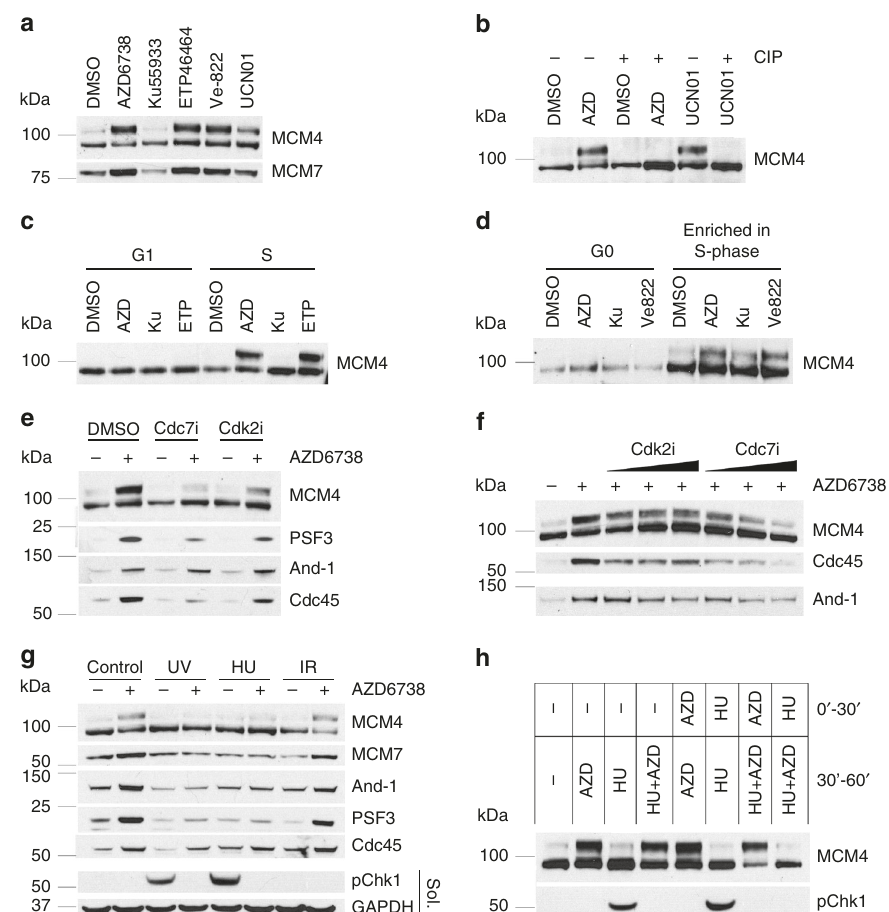
Fig. 2 ATR inhibition causes Cdc7-dependent MCM4 hyperphosphorylation in the chromatin fraction of S-phase cells. Cells were fractionated as described in Methods section. Western blotting of the nuclease-insoluble chromatin fraction is shown. a 293T cells were treated with 5 μ M AZD6738, 10 μ M Ku55933, or 5 μ M ETP46464, 5 μ M Ve-822, or 100 nM UCN01 for 1 h. b 293T cells were treated with 5 μ M AZD6738 or 100 nM UCN01 for 1 h, the nuclease-insoluble fraction was treated with CIP or just incubated at 37 °C. c U2OS cells were synchronized by double thymidine-nocodazole block and then released into mitosis. G1 phase cells (6 h later) or S-phase cells (12 h later) were treated with 5 μ M AZD6738, 5 μ M ETP46464, 10 μ M Ku55933, or DMSO for 1 h. d BJ-hTERT cells were synchronized by contact inhibition and then released by splitting (for S phase 10 h later) or kept con fl uent (for G1 phase). Cells were treated with 5 μ M AZD6738, 5 μ M Ve-822, 10 μ M Ku55933, or DMSO for 1 h. e Cdk2 or Cdc7 inhibitor of 10 μ M were added